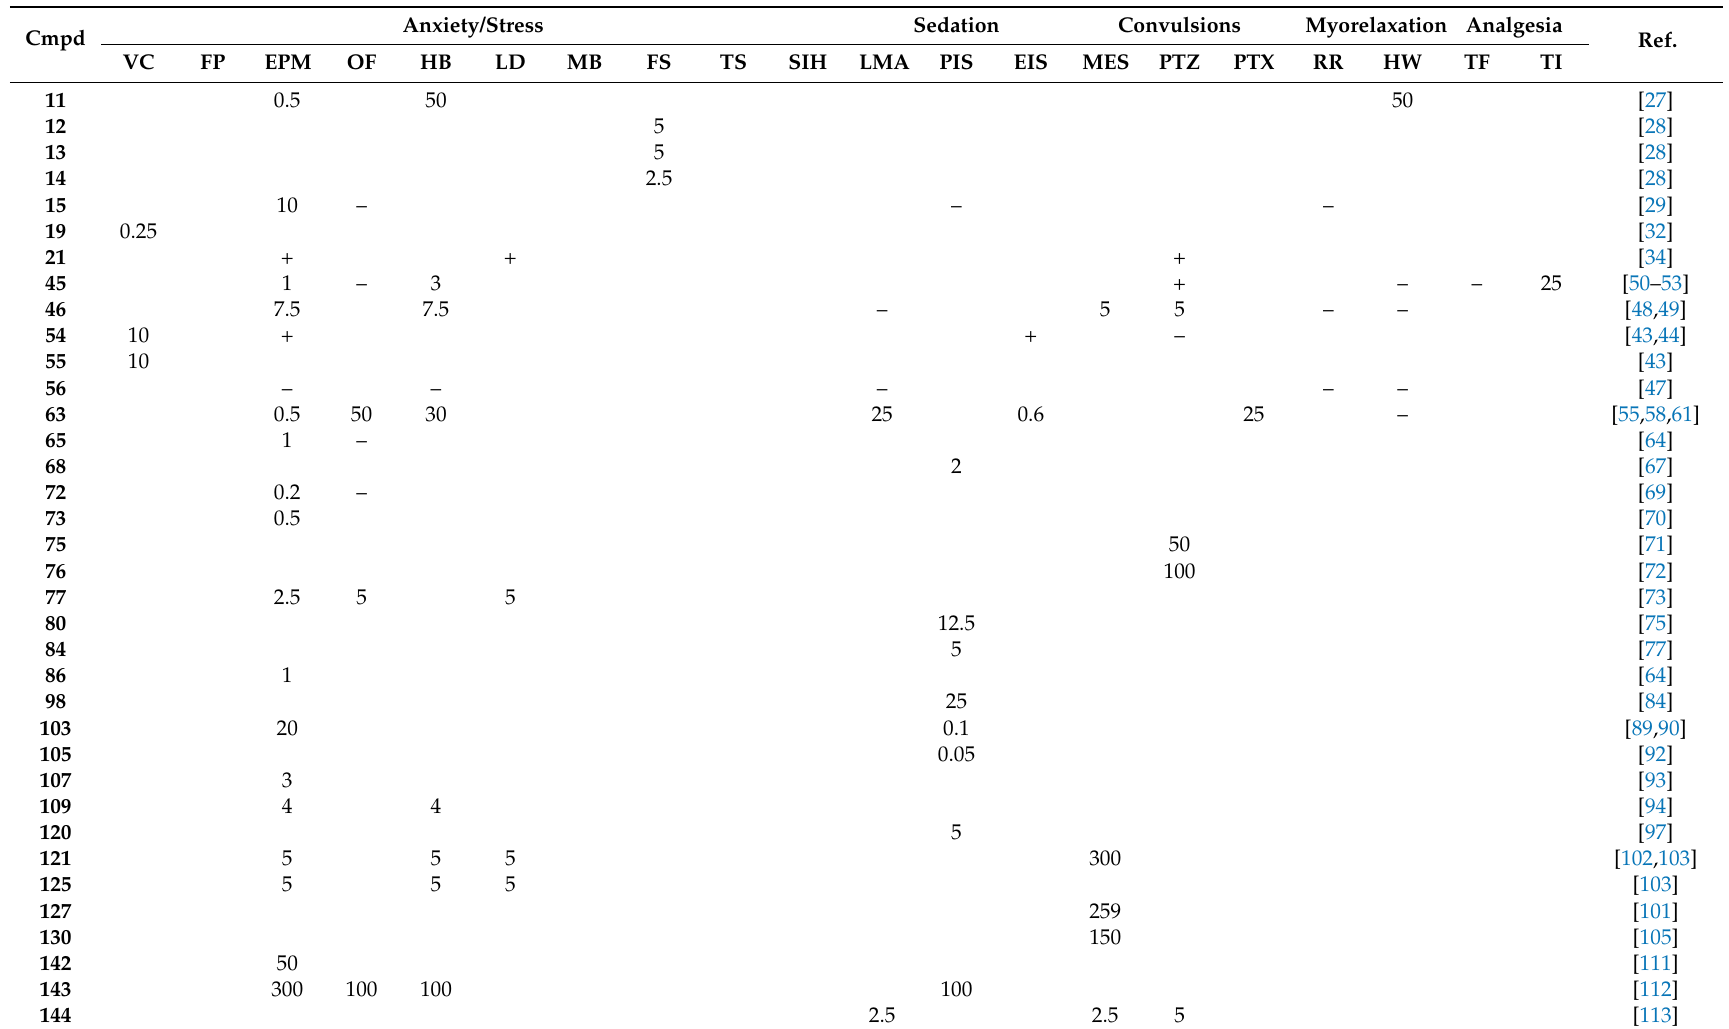
Table 4. Data from in vivo